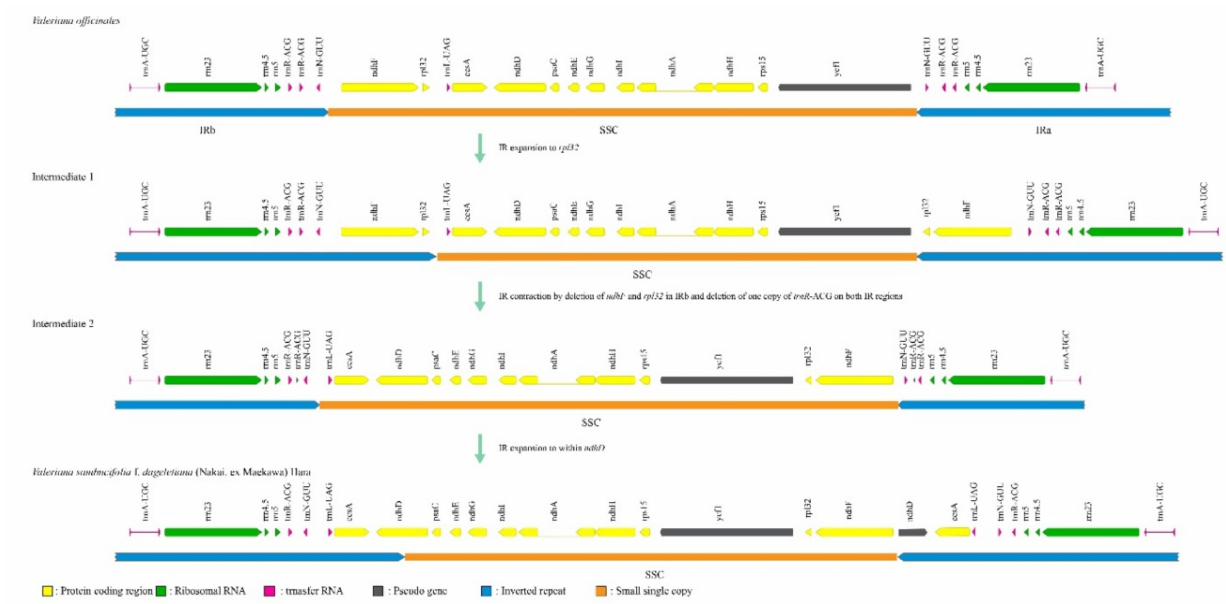
Figure 2. Comparison of inverted repeat (IR) expansion and contraction at the boundaries between IR and single-copy (SC) regions in the plastomes of Valeriana sambucifolia f. dageletiana and Valeriana officinalis